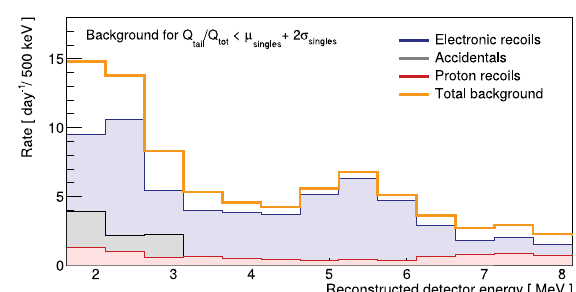
Figure 3. Background energy spectra for the different listed contributions in the IBD region obtained by selecting correlated events having PSD values less than 2 standard deviations from the mean value of the electronic recoil peak for single events. Data taken with reactor turned